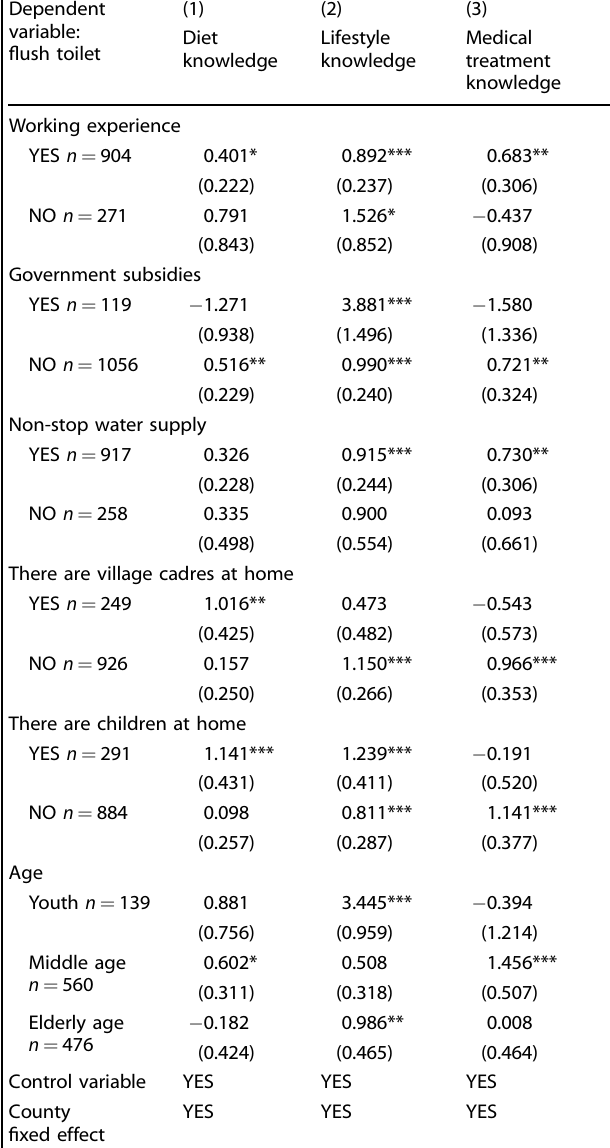
Table 2. Heterogeneity analysis